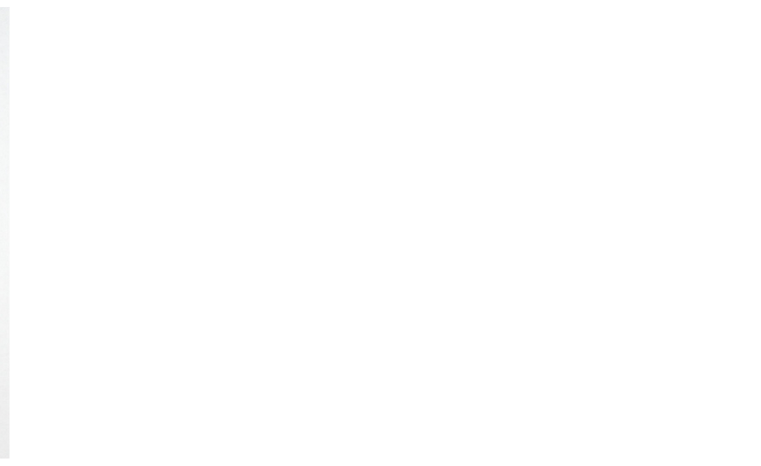
Figure 12. Abyssochrysoid gastropod (IGM 5010b). Scanning electron microscope image showing varix-like ribs and last whorl separating slightly from the previous whorl, forming a channel. Scale bar = 2 mm.